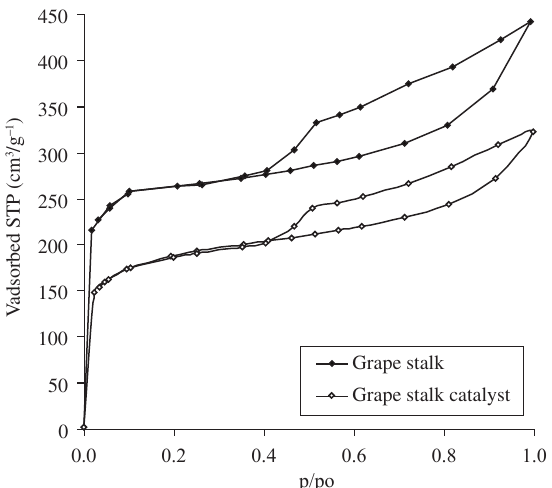
Figure 2. Nitrogen adsorption-desorption isotherms (77 K) for grape stalk AC support and